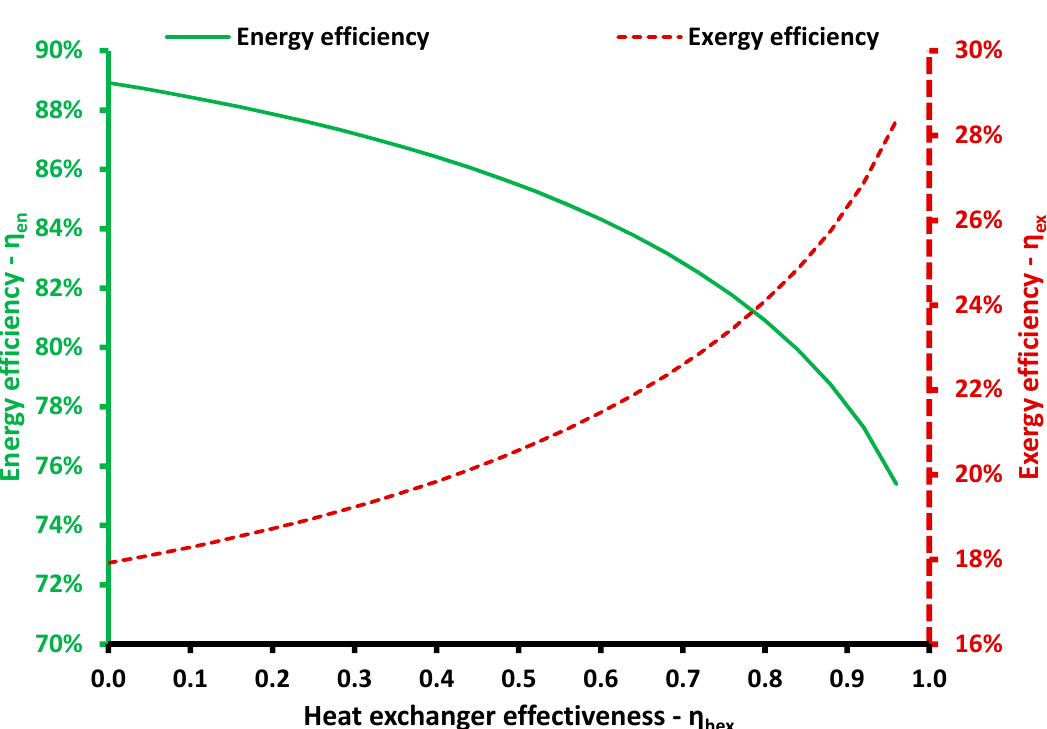
Figure 11. Energy and exergy efficiencies for different values of the heat exchanger effectiveness.